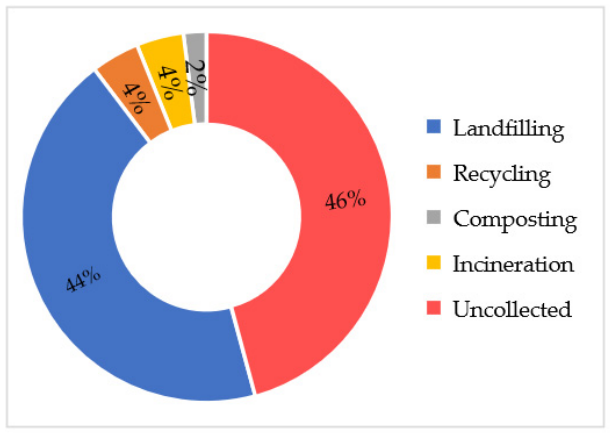
Figure 4. MSW treatment in the country (authors’ own calculation based on [18,24]).